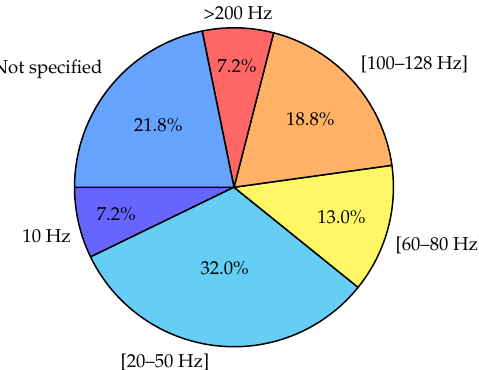
Figure 6. Distribution of sampling frequency among all articles. Note that three articles use sampling rates increasing from 10 Hz to 200 Hz in 10 Hz increments. They are thus counted in each corresponding slice of the pie